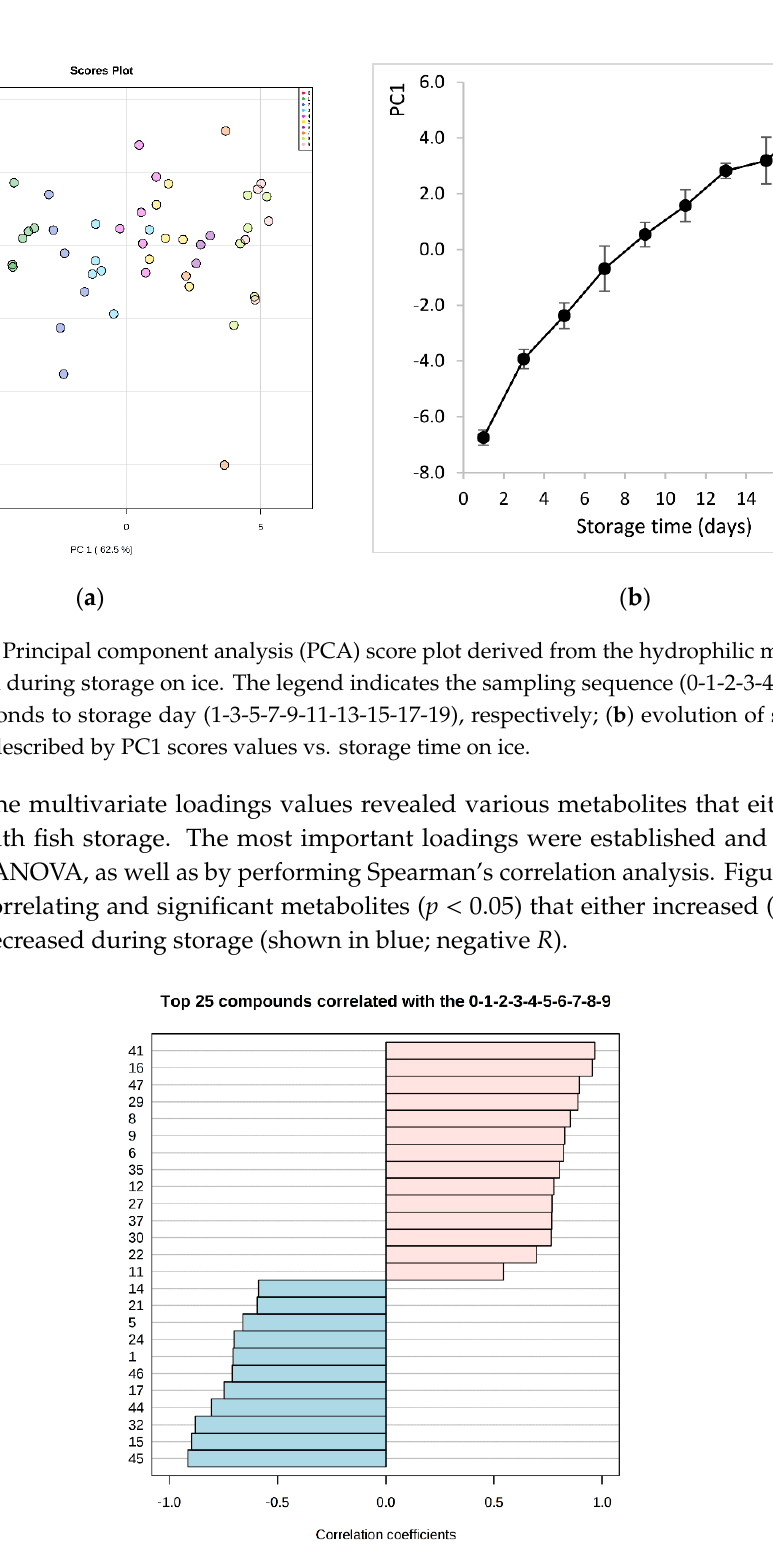
Figure 3. Pattern recognition—Spearman’s correlation analysis showing the top 25 metabolite features correlated significantly with sampling sequence (0-1-2-3-4-5-6-7-8-9 is equivalent to storage day 1-3-5-7-9-11-13-15-17-19). Each row represents the most significant metabolite identified from the test ( p < 0.05). The x -axis shows correlation score, whereas the y -axis corresponds to gas chromatography–mass spectrometry (GC–MS) peak number from peak index (see Table 1).